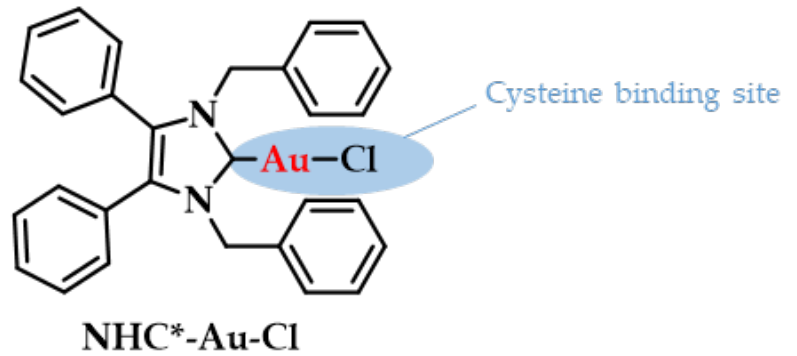
Figure 8. Chemical structure of NHC*-Au-Cl highlighting the albumin binding site. Adapted with permission from Ref. [117]. Copyright (2018) Wiley-VCHVerlag GmbH & Co. KGaA, Weinheim .